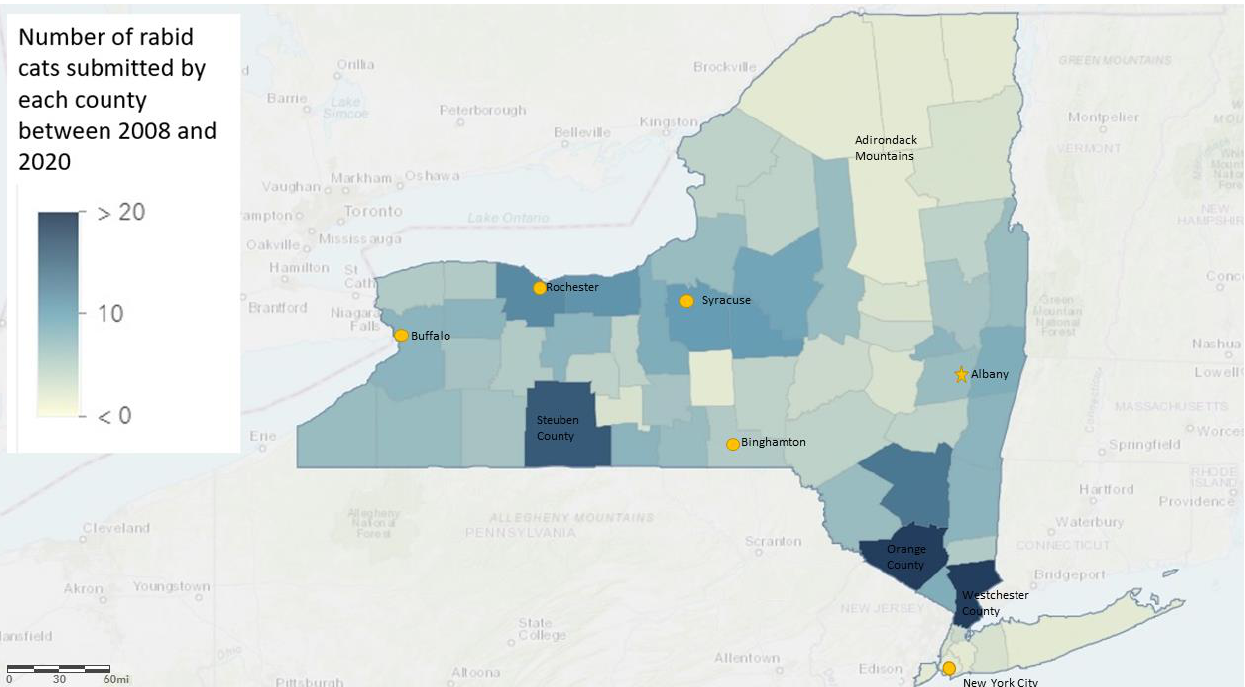
Figure 3. Ownership and vaccination status of rabies-positive cats submitted to the NYSDOH Rabies Laboratory that had either bitten or scratched a human.